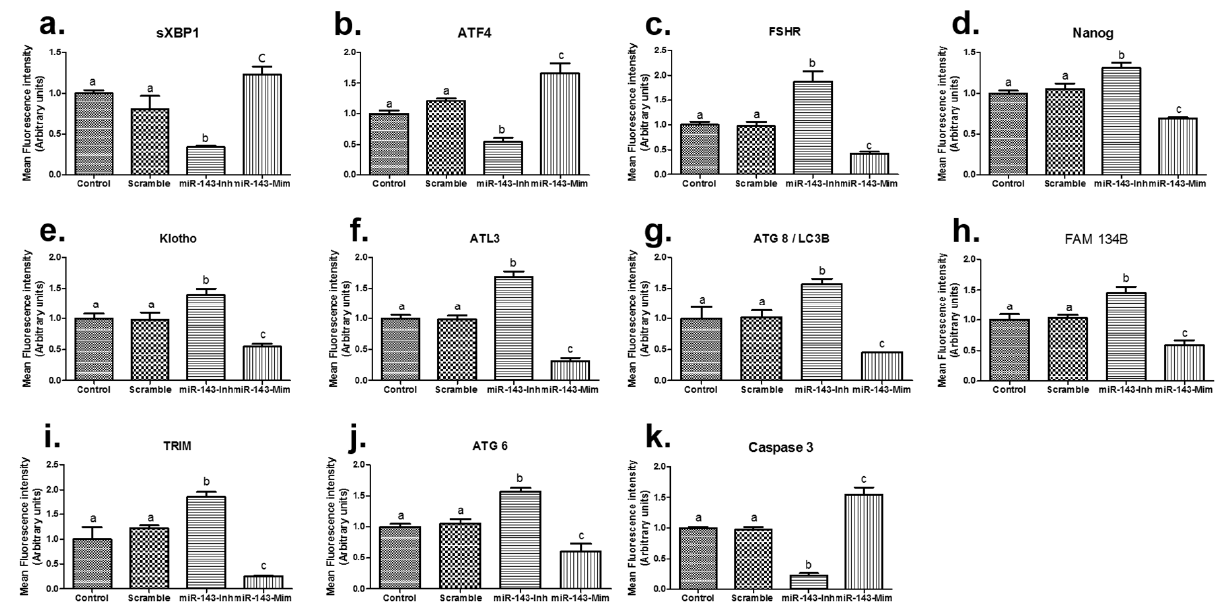
Figure 3. mRNA expression levels of genes associated with ER stress, ER-phagy, embryo quality, and apoptosis in cleavage stage embryos on Day 2 after microinjection ( a–k ). Data are presented as standard error of the mean (±SEM). The experiment was performed using at least three technical replicates during qRT-PCR analysis, on mRNA obtained from at least 400 embryos per sample and nine biological replicates. Groups labeled with different lowercase letters indicate statistically significant differences ( p < 0.05). Scale bars = 50 μ m, magnification = 400x. miR-143-Inh = microRNA 143-Inhibitor, miR-143-Mim = microRNA 143-Mimic.